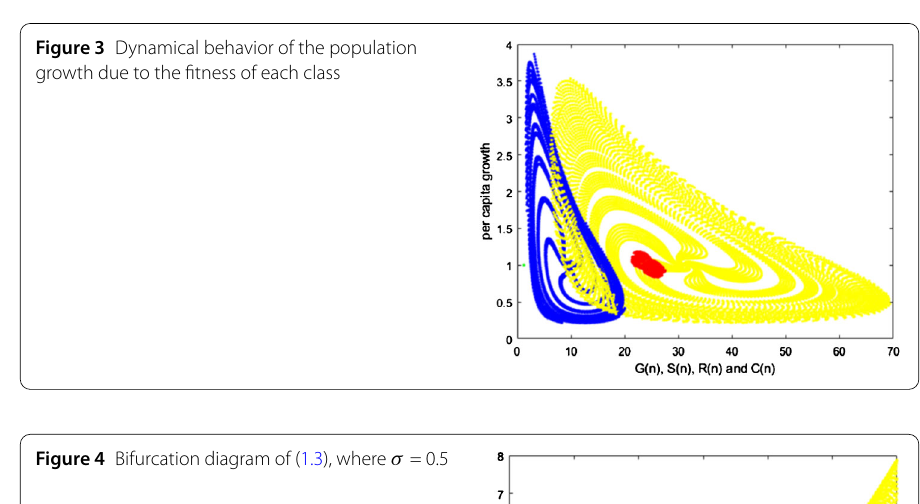
Figure 4 Bifurcation diagram of (1.3), where σ =